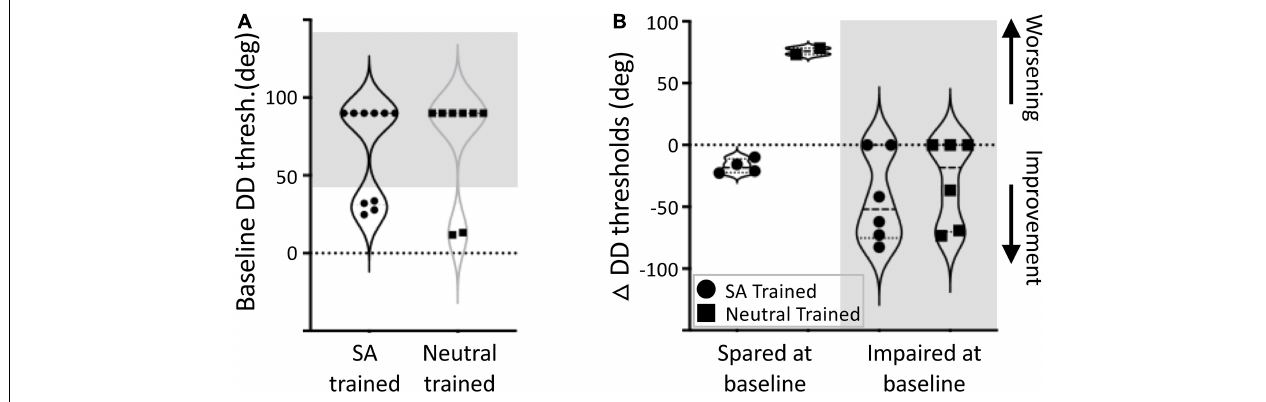
FIGURE 4 | Change in direction difference (DD) thresholds sorted by baseline performance. (A) Blind-field training locations were categorized as “impaired” at baseline if DD threshold was > 45 ◦ (shaded region), or as relatively “spared” if DD threshold was < 45 ◦ . Four SA- and two Neutral-trained participants had a single location each categorized as having “spared” vision. Four SA- and two Neutral-trained participants had a single location each categorized as “impaired” prior to training, whereas one SA and two Neutral-trained participants were impaired at baseline at both of their training locations. (B) Spared locations (white region), when SA-trained, maintained their spared performance or slightly improved; when such locations were Neutral-trained, performance became significantly worse. For both training cohorts, when initial performance was impaired (shaded region), improvements were seen in about half of the participants; the rest showed no